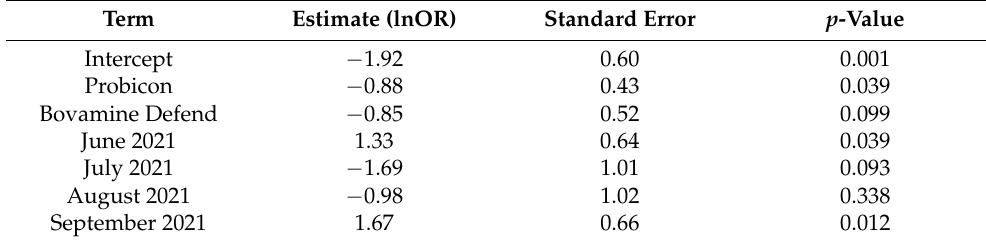
Table 2. Results of the GEE analysis for E. coli O157:H7 prevalence.